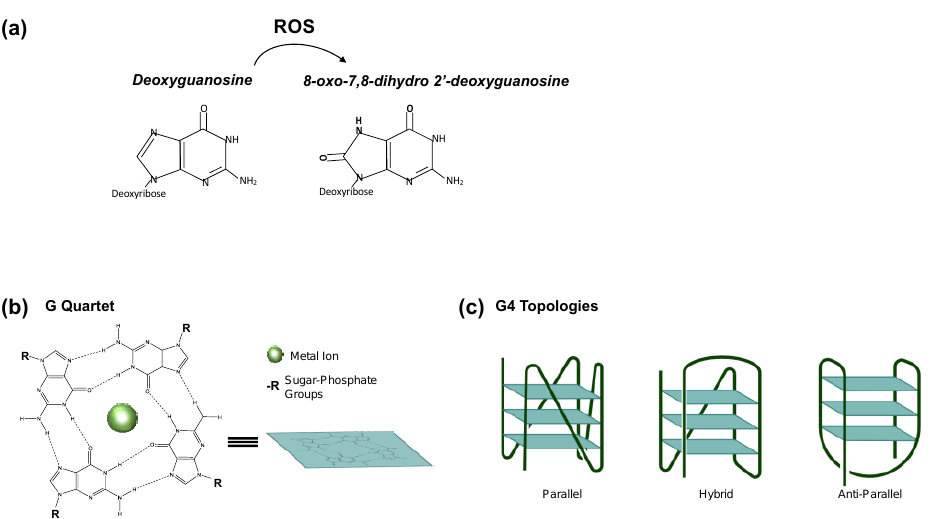
Figure 1. ( a ) 8-oxo-7,8-dihydro-deoxyguanosine (8-oxodG) chemical structure. 8-oxodG is produced when ROS oxidizes 2′ -deoxyguanosine. ( b ) Schematic representation of G-quadruplex structures. ( c ) Depending on the relative orientation of the DNA strand within the structure, specific G4 topologies can be created, including anti-parallel, parallel and hybrid structures.